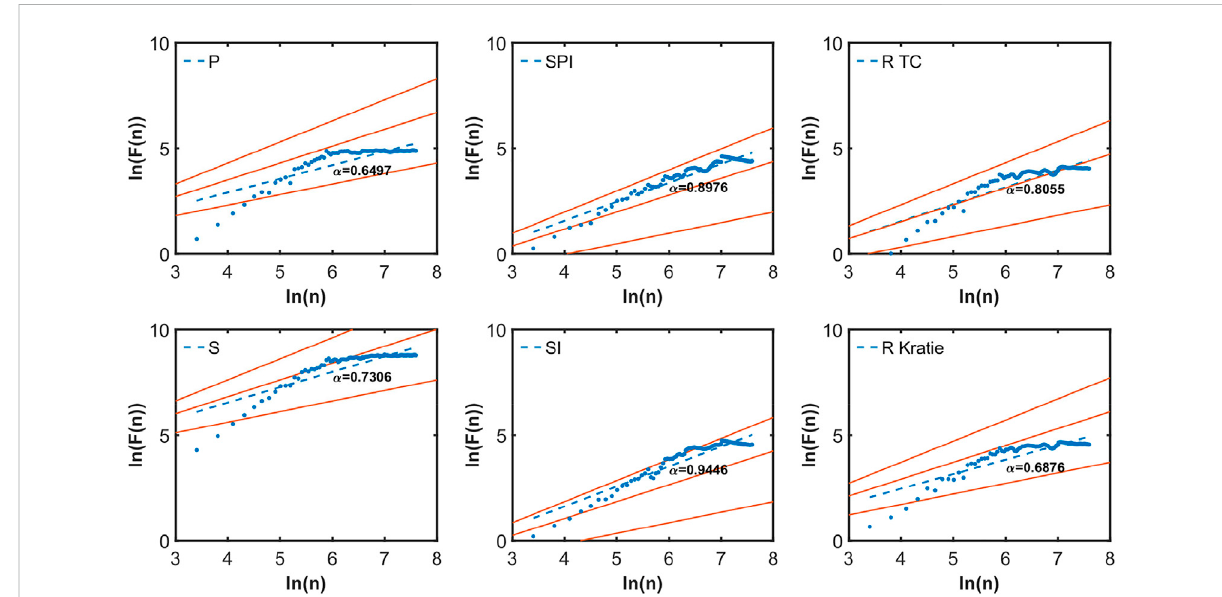
FIGURE 12 Doublelogarithmicplotsofthe fl uctuationfunctionsofDFA versus window-sizenderivedfromP,S,SPI,SI,and in-situ runoffattheTC-CDand Kratie stations. The slopes of dashed blue lines represent the fi tted α DFA , and the three red solid lines from top to bottom denote α DFA (cid:1) 1, α DFA (cid:1) 0 . 8, and α DFA (cid:1) 0 . 5, respectively.